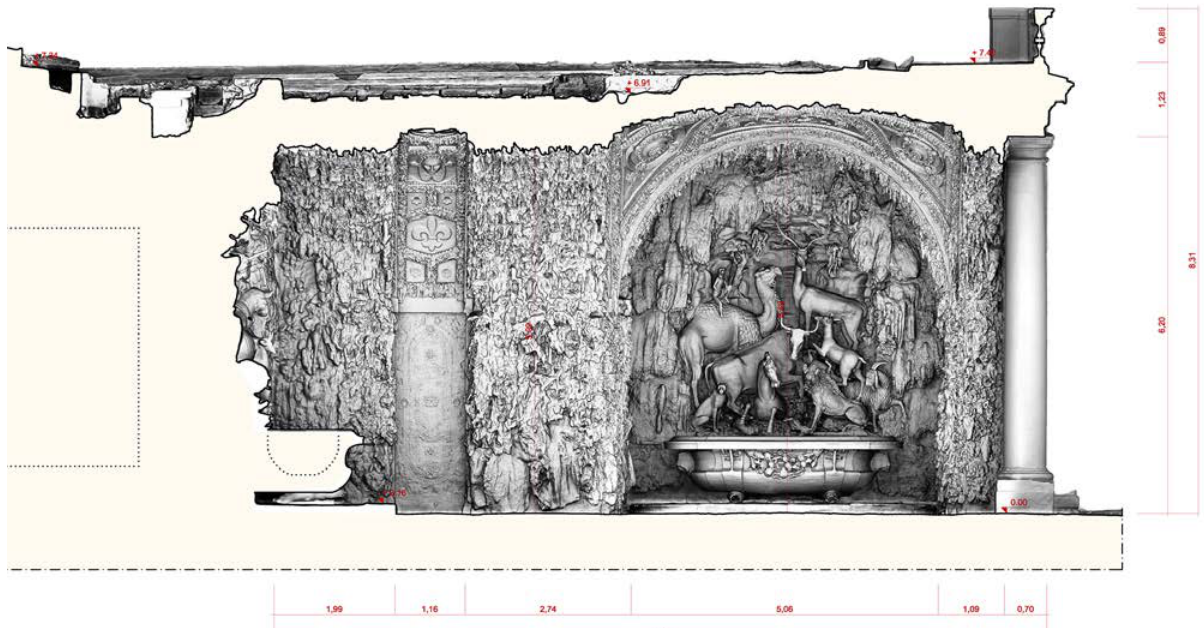
Figure 7. Longitudinal section of the Grotto of